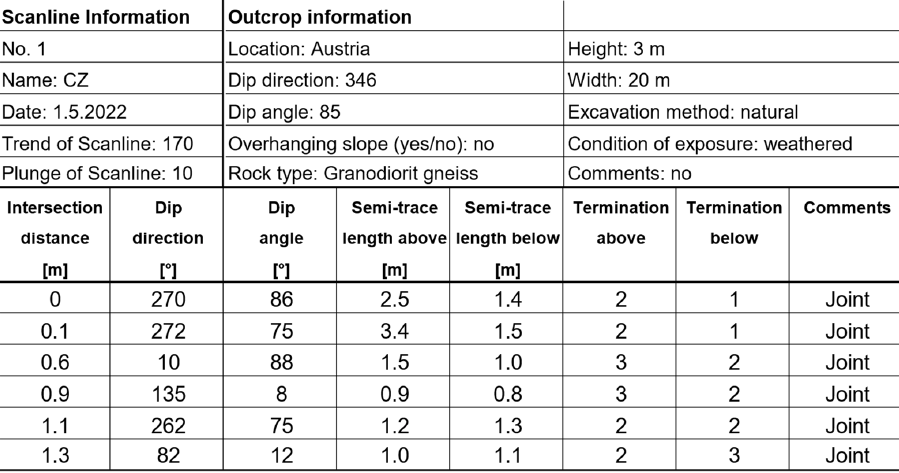
Figure 1. Scanline survey logging sheet (modified after